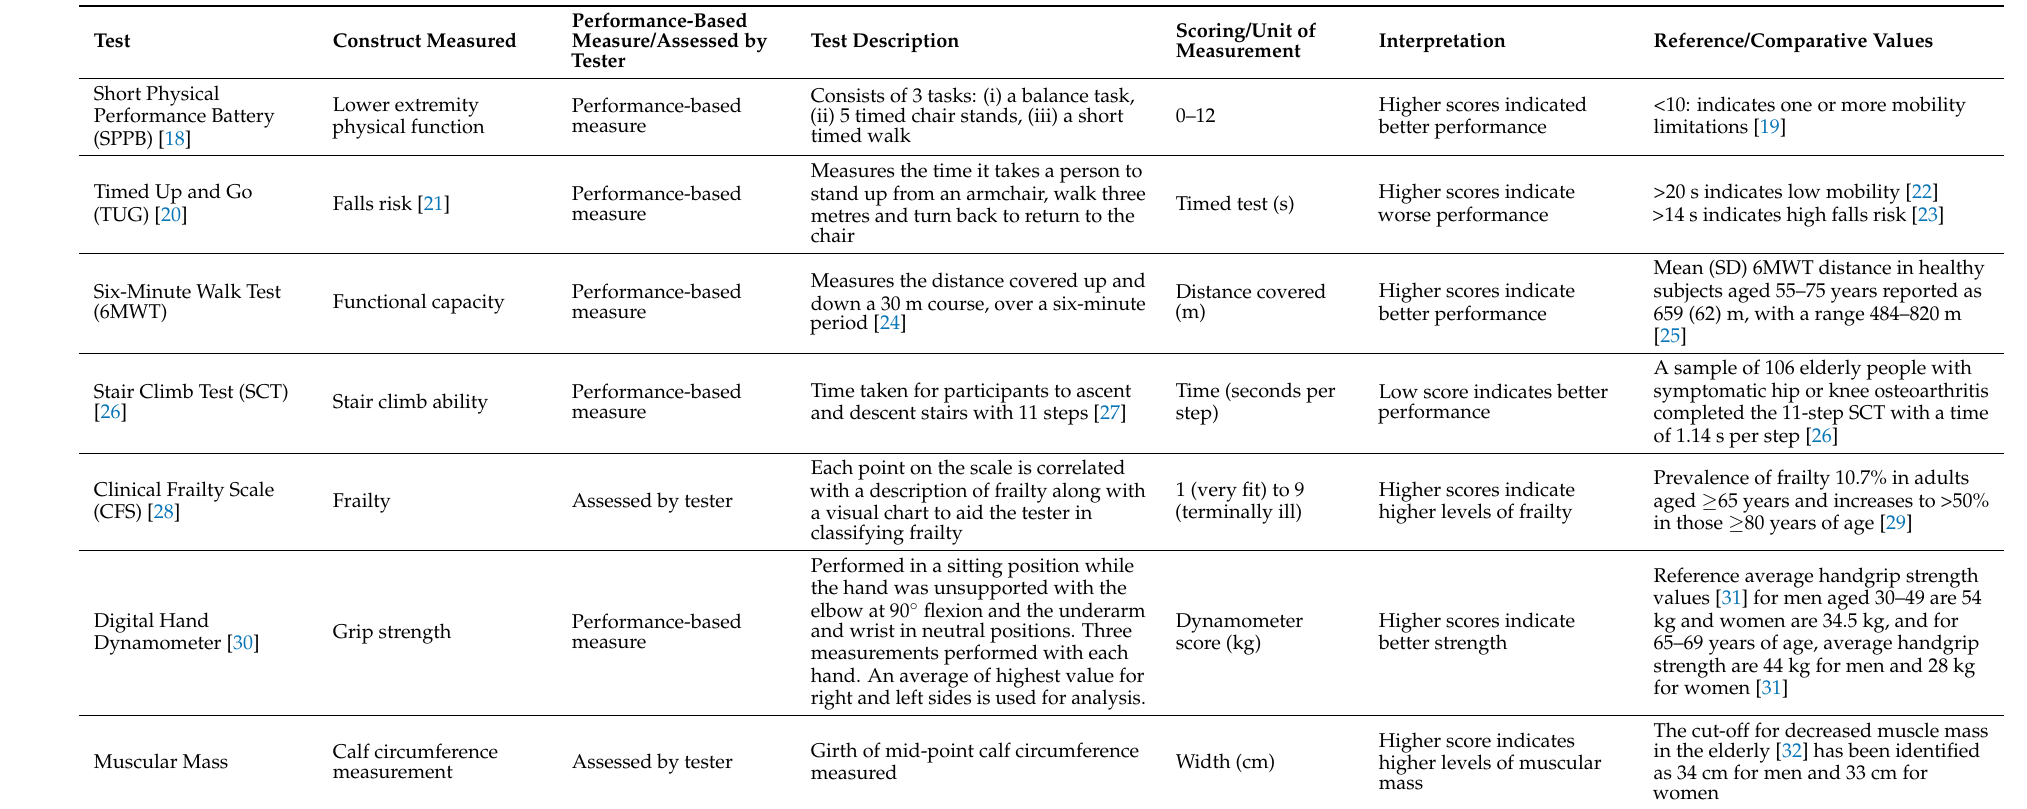
Table 1. Summary of test